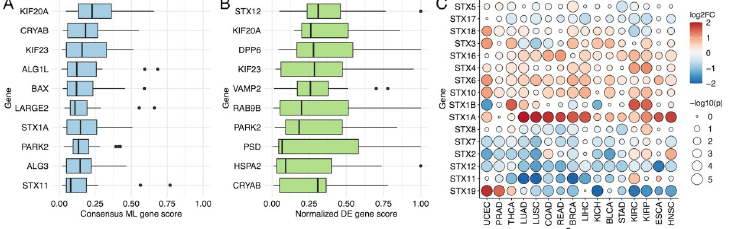
Fig 3. Kinesins and components of the SNARE complex are associated with cancer status. Boxplots show the ( A ) consensus ML gene scores and ( B ) normalized DE gene scores among the different cancer types. Only the top 10 scoring genes on average for each scoring type are shown. ( C ) Log-transformed expression fold-changes and significance (FDR-adjusted p-values) of PSP genes belonging to the STX family, from the DE analysis. Color indicates fold-change magnitude and direction, whereas circle size indicates